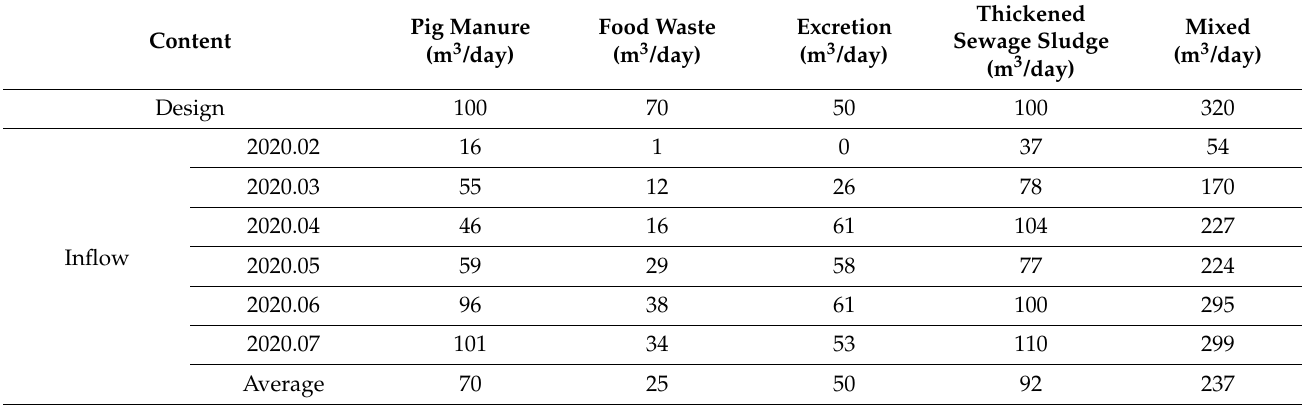
Table 5. Monthly discharge of organic